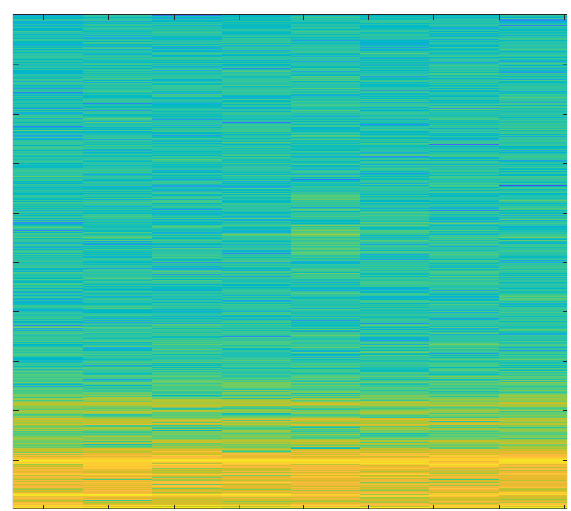
Figure 14. Softwood, New Tool, 1 mm depth-of-cut.